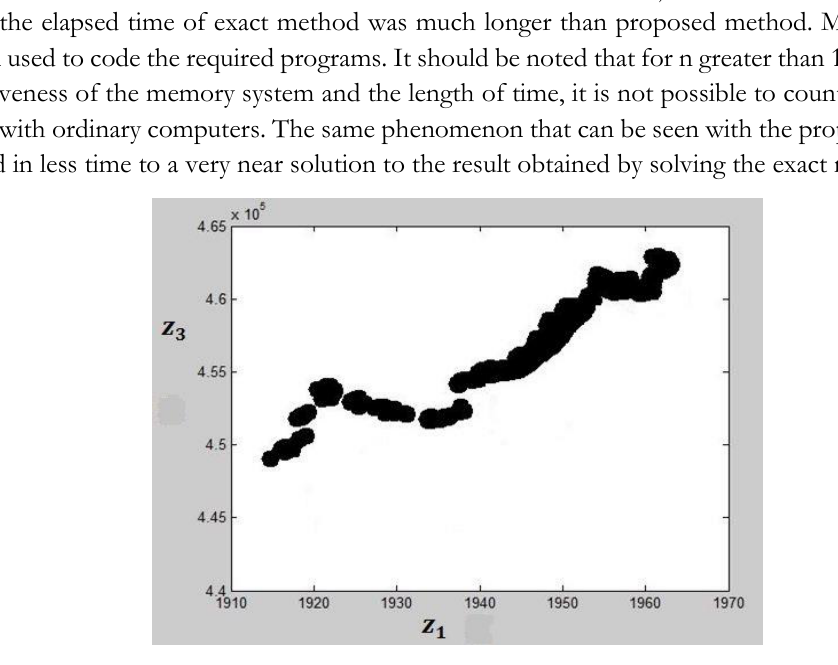
Fig. 8. Quality Paret o frontier, towards the cost.